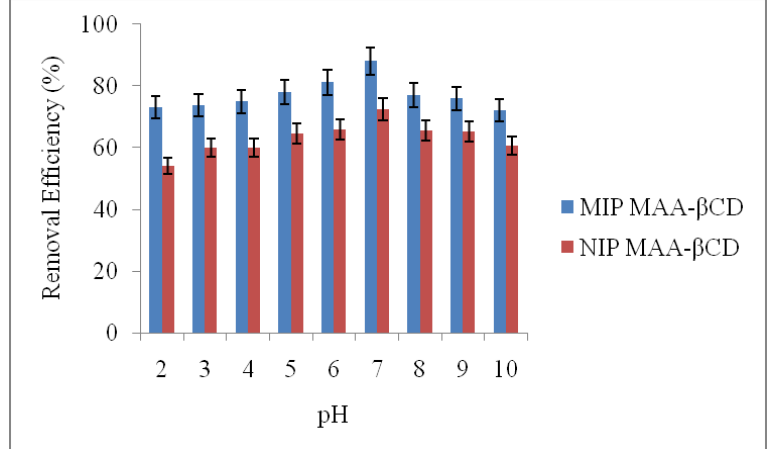
Figure 4. Effect of pH on the adsorption of 2,4-DCP onto MIP MAA-βCD and NIP MAA-βCD (Adsorption conditions: adsorbent dose = 20 mg, initial concentration = 10 mg·L −1 , solution volume = 10 mL, T =298 K, time = 2